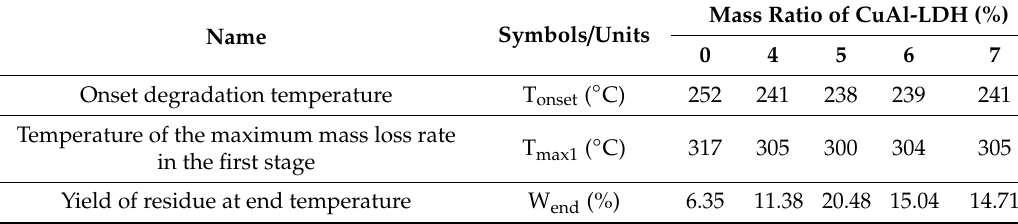
Figure 3. TG curves for the pyrolysis of pure PVC and its composites. Table 2. Dynamic TGA results for the pyrolysis of PVC and its composites.